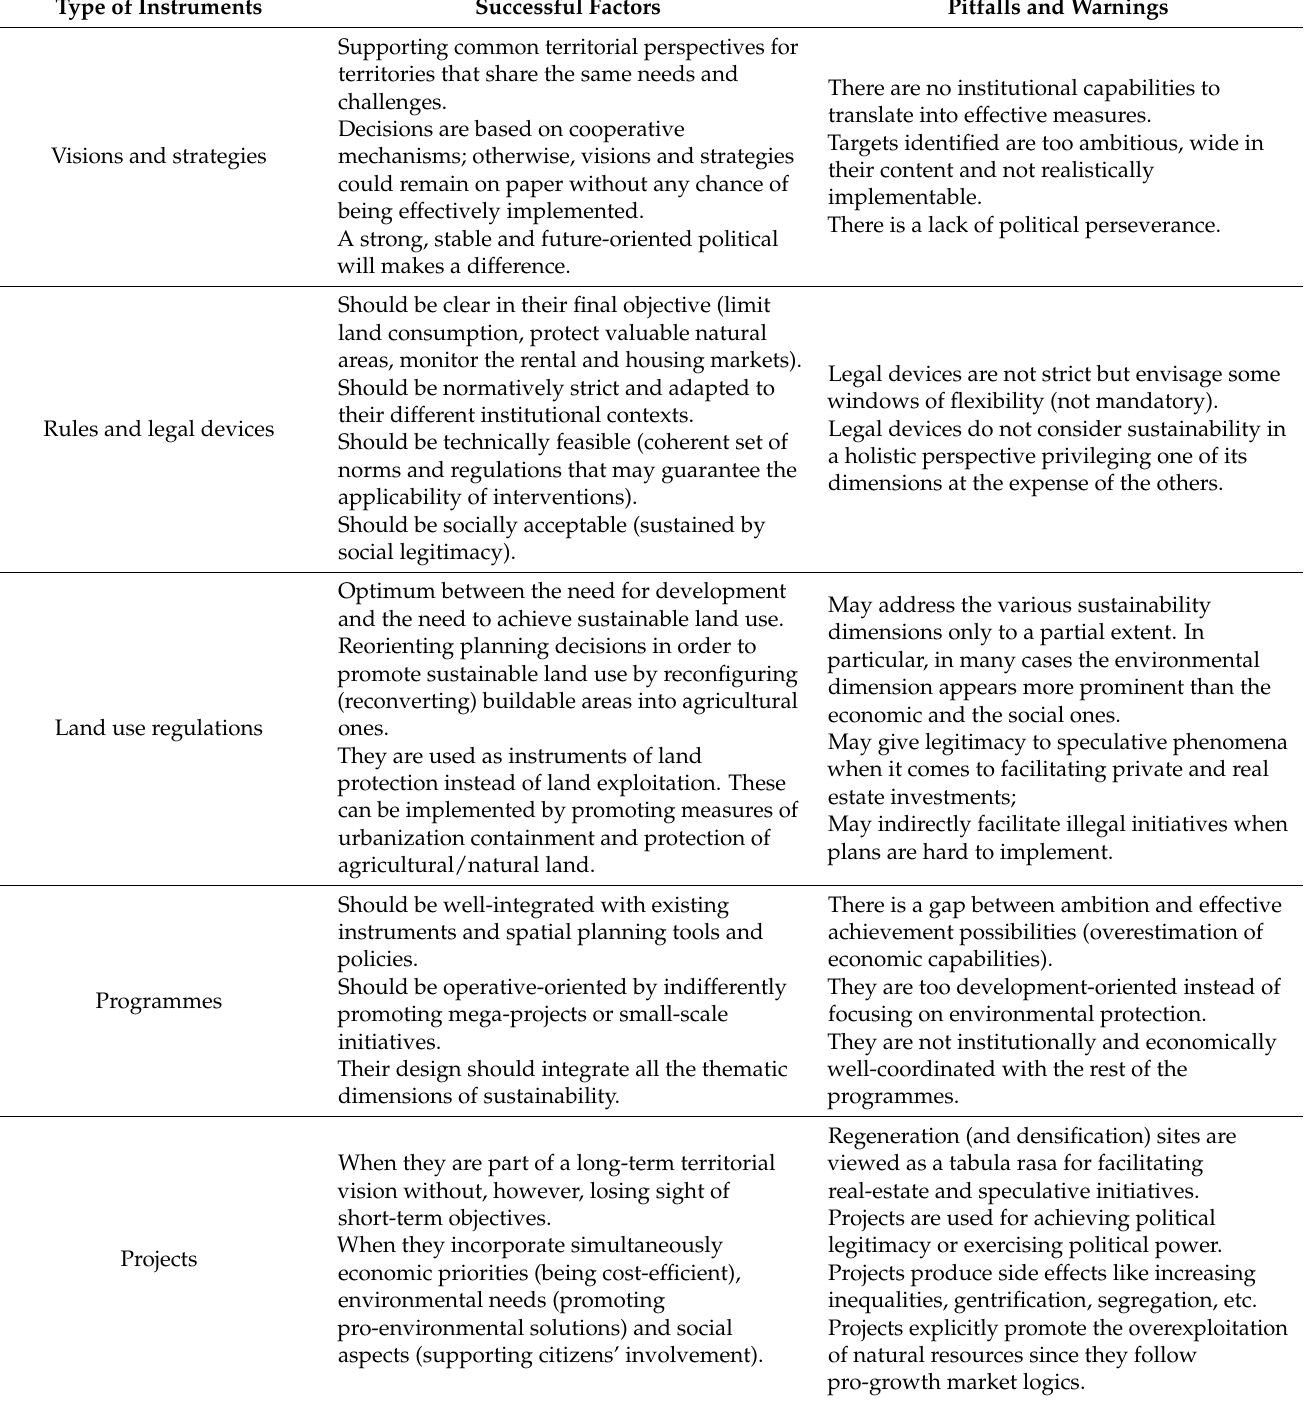
Table 5. Successful factors and pitfalls when it comes to promoting sustainable land use (authors’ own elaboration). Type of